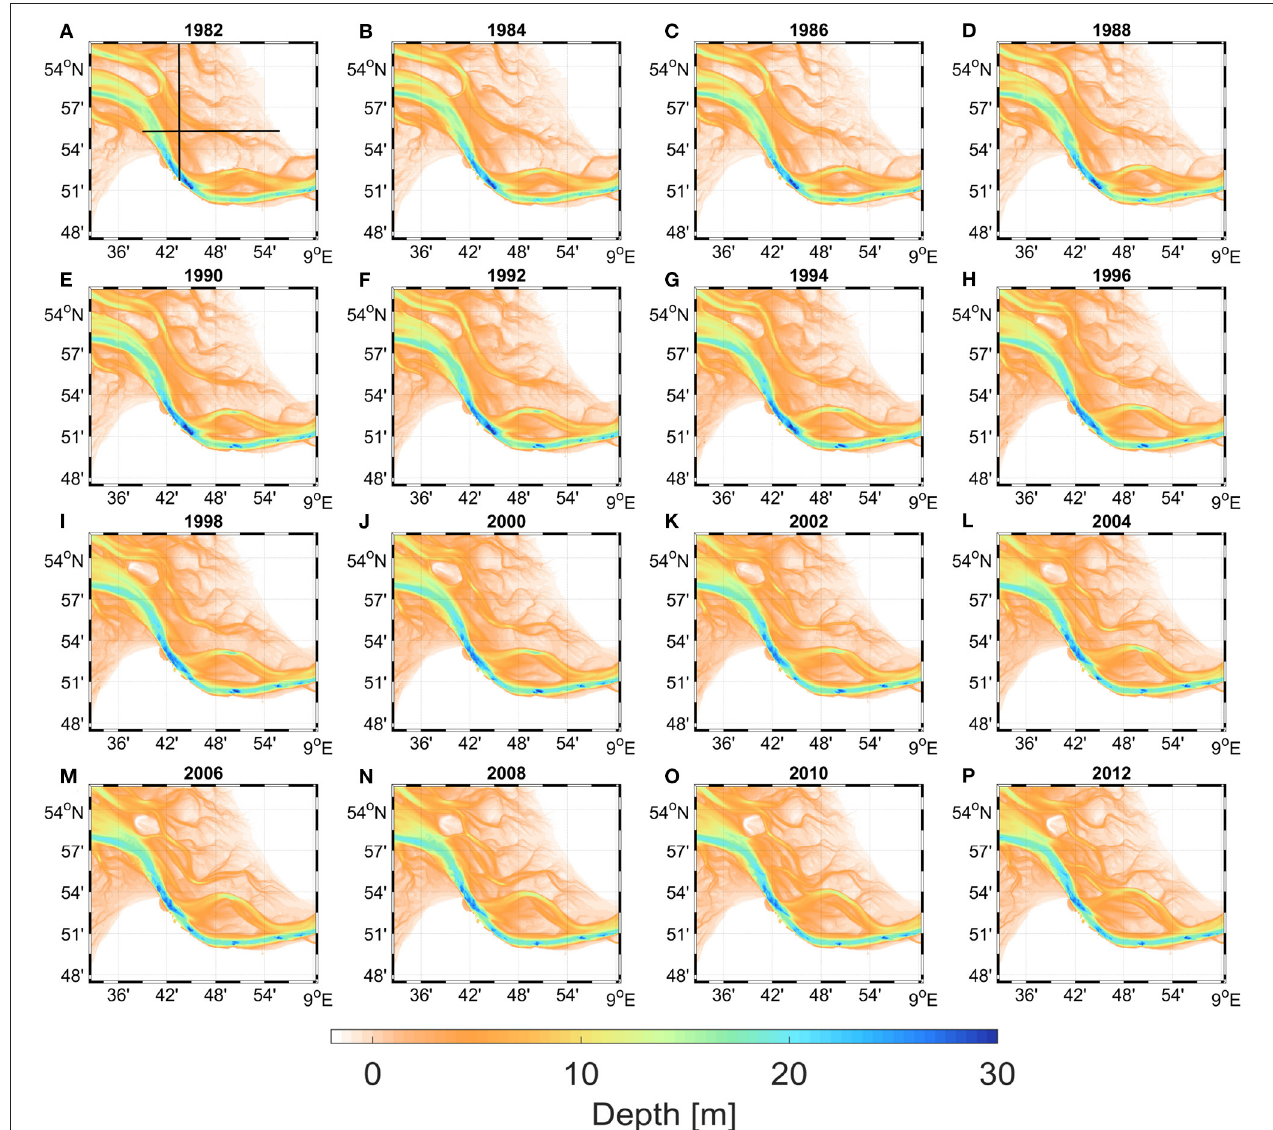
FIGURE 3 | Temporal-spatial evolution of the bathymetry west of the Elbe Estuary illustrated as consequent bathymetric maps plotted for every second year (A–P) . Black lines in (A) show locations of meridional and zonal transects, for which the bathymetric development is shows as time vs. distance diagrams in Figure 4